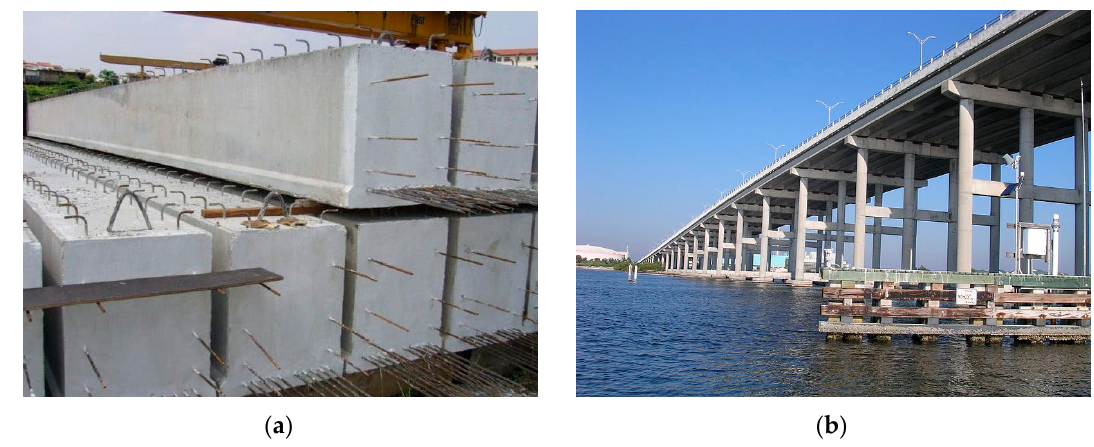
Figure 13. Reinforced composite (RC) beams ( a ), concrete bridge ( b ), reproduced from [184,185] under open access